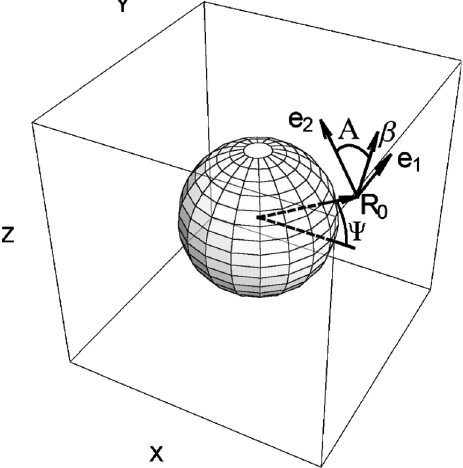
p (cid:5) ^ z (cid:7) ^ x (cid:6) , and ^ x 2